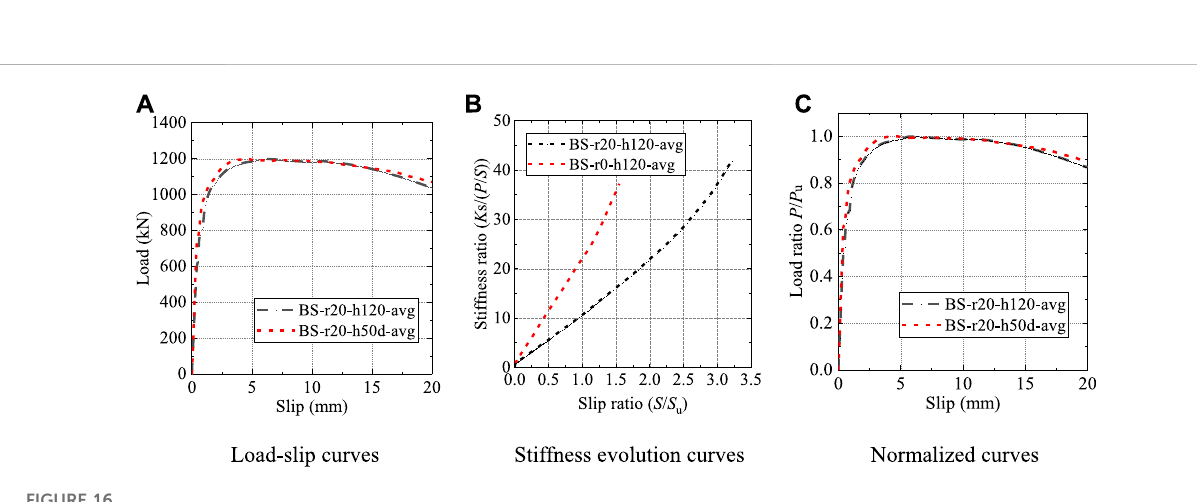
failure modes, load-slip curves, shear capacity and shear stiffness. Figure 12 shows the comparison of the deformation of the B-S connectors in the tests and FE analysis. Both in the push-out tests